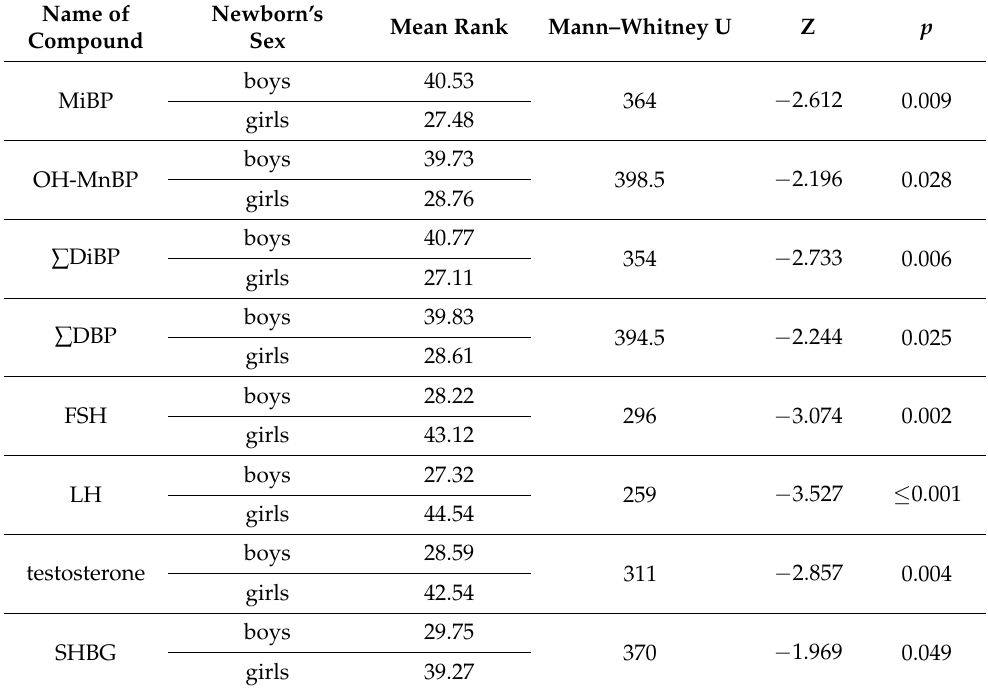
Table 7. Comparison of phthalate concentrations between mothers with male and female